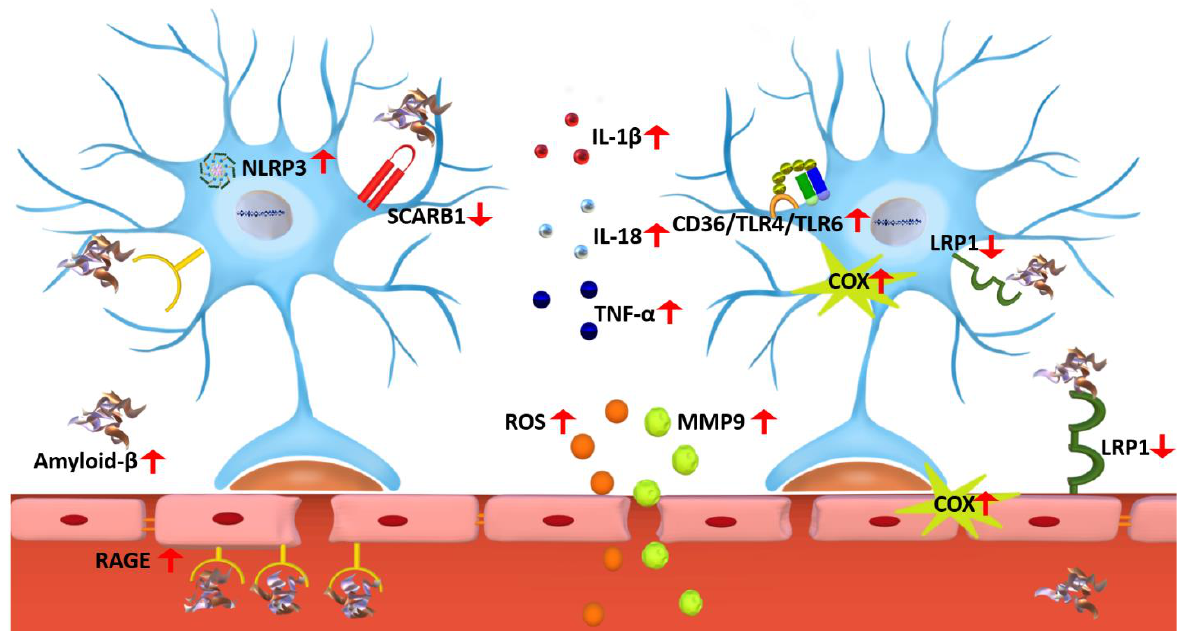
Figure 2. A representative scheme demonstrates astrocytes’ interaction with the BBB and the neuroinflammation effect mediated by astrocyte activation on the BBB function. In AD, reduced expression of astrocytic SCARB1 and LRP1 would decrease the clearance of Aβ. Reactive astrocytes produce a wide range of cytokines and other inflammatory markers such as ROS, RAGE, COX, and MMP9 due to NLRP3 inflammasomes and NF- κB pathways activation. In addition, TLR4 and TLR6 activation through binding to CD36 would increase proinflammatory cytokines secretion leading to neuroinflammation and BBB dysfunction. In AD, the expression of endothelium RAGE and LRP1 are upregulated and downregulated, respectively, which lead to reduced LRP1- mediated clearance of Aβ, and increased RAGE- mediated Aβ influx into the brain, which would further increase the vicious cycle of brain Aβ accumulatio n, astrocytes activation, and BBB dysfunction.Astro- cytes, and microglia, could also be activated via TLRs. TLRs are pattern recognition recep- tors (PRR) that recognize and bind substrates and activate the immune response [186]. TLR could be expressed on the cell surface as TLR1, 2, 4, 5, 6, and 10 or intracellular as TLR 3, 7, 8, and 9, and their expression varies among immune cells [186]. In the immune cells of human AD brains, TLR mRNA is overexpressed except for TLR2, which is not changed [186] . Aβ is a substrate for TLR ; upon binding, it stimulates its overexpression [187] . Recent research showed that while Aβ 42 did not affect the expression of TLR3, it increased its reactivity in cultured microglial cells [188]. TLR4 antagonists could reduce neuroinflammation in AD, yet they might interfere with Aβ clearance by lowering the microglial phagocytotic ability of Aβ . In contrast, TLR4 agonists might have a beneficial role in Aβ clearance but not in reducing neuroinflammation [189]. Other researchers re- ported that the deletion of TLR2 in APPswe/PSEN1dE9 transgenic mice caused cognitive impairment, and increased anxiety, white matter damage, and brain atrophy in an Aβ - independent pathway [190], which collectively highlights the controversy regarding the role of TLR in AD [191]. The activation of TLR can be initiated through binding CD36 (cluster of differentia- tion 36) and TAM (Tyro3, Axl, and Mer) receptors. CD36, a scavenger membrane receptor known as fatty acid translocase (FAT), has a role in fatty acid transportation and is ex- pressed in the endothelial cells of the BBB and glial cells [192]. Under normal conditions, this receptor helps clear Aβ across the BBB and through phagocytosis by the astrocytes [193]. In AD, CD36 forms a complex with TLR4 and TLR6 that is responsible for the